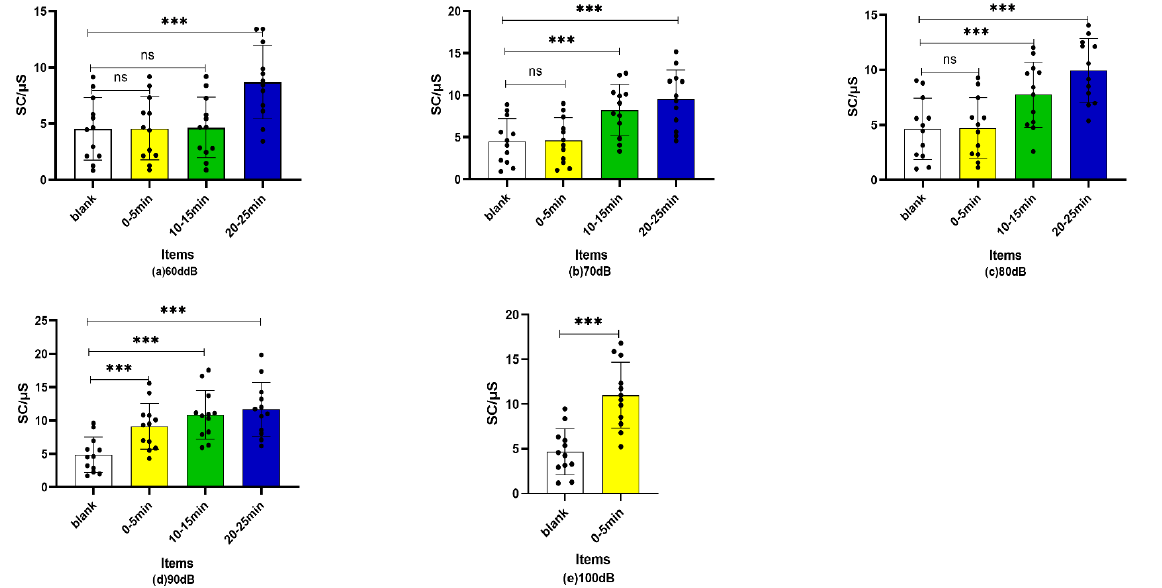
Figure 3. Bar graph of skin conductivity under five noise levels. “ns” means no significant difference, “***” means have significant